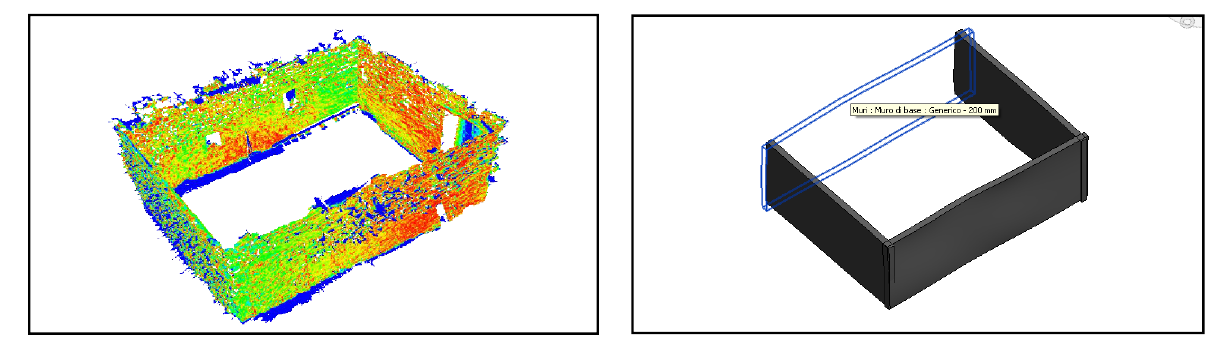
Figure 7. 3D Revit model of irregular stone walls